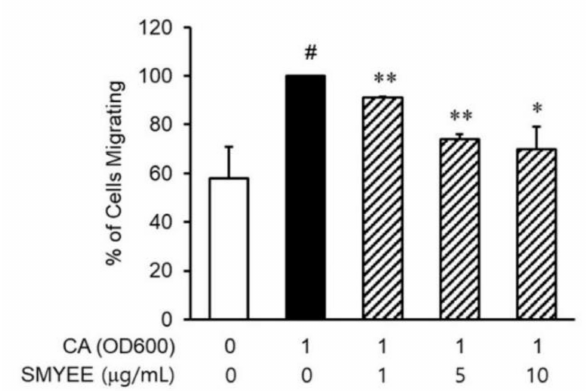
Figure 4. E ff ects of Sargassum miyabei Yendo ethanolic extract (SMYEE) on in vitro migration of human neutrophil-like HL-60 (dHL-60) cells. The cells were added to the upper chambers of Transwell cluster plates separated from the lower chambers by 3- µ m-pore-diameter filters. Cutibacterium acnes ( C. acnes )-induced HaCaT cells were added to the lower chambers. A hemocytometer was used to count the number of dHL-60 cells that migrated to the lower chambers. The data are means ± standard error of the mean (SEM) and are representative of the results obtained in three independent experiments. # p < 0.05 vs. the no-treatment group; * p < 0.05 and ** p < 0.005 vs. the C. acnes group. CA: C. acnes